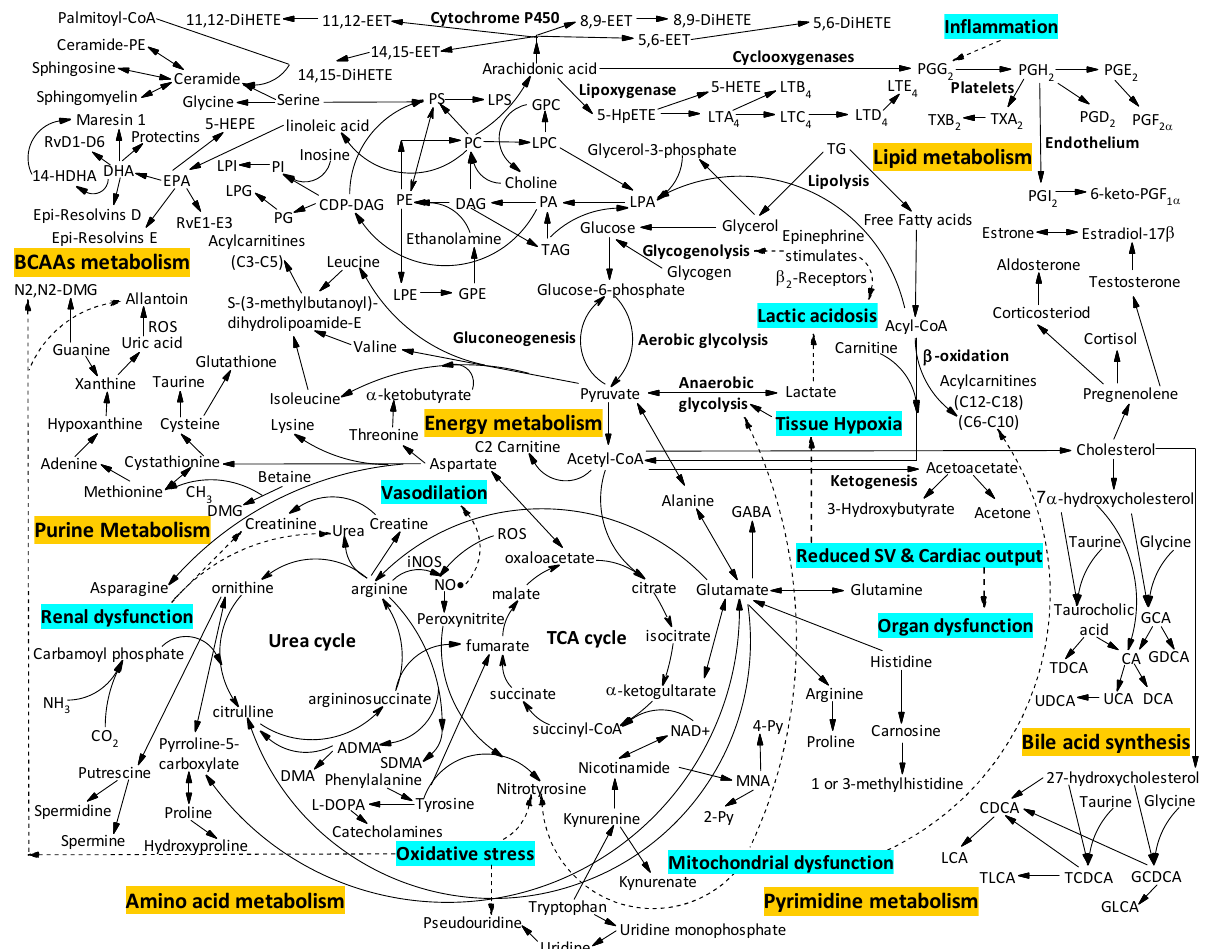
Figure 1. Main metabolic pathways involved in the pathology of sepsis identified using the Kyoto encyclopedia of genes and genomes (KEGG) [41]. Pathways highlighted in yellow correspond to metabolic derangements in sepsis and are related to: bile acid synthesis; energy metabolism; amino acid metabolism; purine and pyrimidine metabolism; lipid metabolism. The eight pathophysiolog- ical processes implicated in the metabolic response to sepsis are highlighted in turquoise: renal dys- function; vasodilation; oxidative stress; mitochondrial dysfunction; lactic acidosis; tissue hypoxia; reduced stroke volume and cardiac output and organ dysfunction. Abbreviations: TG = triglyceride; PS = phosphatidylserine; PC = phosphatidylcholine; PE = phosphatidylethanolamine; PG = phos- phatidylglycerol; PI = phosphatidylinositol; PA = phosphatidic acid; LPC = lysophosphatidycholine; LPE = lysophosphatidylethanolamine; LPG = lysophosphatidylglycerol; DAG = diacylglycerol; LPI = lysophospatidylinositol; TAG = triacylglycerol; DHA = docosahexaenoic acid; EPA = eicosapen- taenoic acid; DiHETE = dihydroxyeicosatetraenoic acid; EET = epoxyeicosatrienoic acid; HpETE = hydroperoxy-eicosatetraenoic acid; HETE = hydroxyeicosatetraenoic acid; HDHA = hydroperoxy- docosahexaenoic caid; HEPE = hydroxypentaenoic acid; TX = thromboxanes; LT = leukotrienes; PGG 2 = prostaglandin G 2 , PGH 2 = prostaglandin H 2 ; PGE 2 = prostaglandin E 2 ; PGI 2 = prostaglandin I 2 ; PGF 2α = prostaglandin F 2α ; keto-PGF 1α = keto-prostaglandin F 1α ; Rv = resolvin; CoA = coenzyme A; TCA = tricarboxylic acid; CA = cholic acid; DCA = deoxycholic acid; TDCA = taurodeoxycholic acid; GDCA = glycodeoxycholic acid; CDCA = chenodeoxycholic acid; LCA = lithocholic acid; GCDCA = glycochenodeoxycholic acid; TLCA = taurolitocholic acid; GLCA = glycolithocholic acid; DMG = dimethylglycine; DMA = dimethylamine; ADMA = asymmetric dimethylarginine; SDMA = symmetric dimethylarginine; GABA = γ-aminobutyric acid; NAD = nicotinamide adenine dinucle- otide; 2-Py = N1-methyl-2-pyridone-5-carboxamide; 4-Py = N1-methyl-4-pyridone-5-carboxamide; L-DOPA = levodopa; NH 3 = ammonia; CO 2 = carbon dioxide; ROS = reactive oxygen species; CH 3 = methyl; NO = nitric oxide; iNOS = inducible nitric oxide synthase; SV = stroke volume.